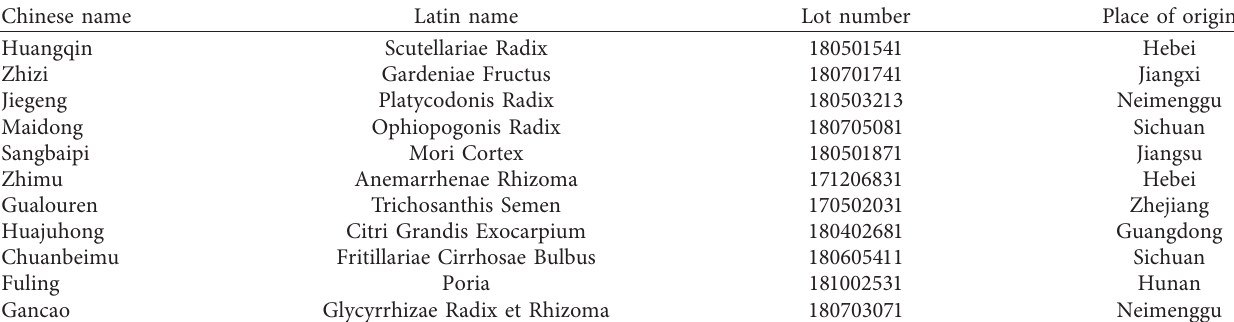
Table 1: Sources of the herbal materials of Qing Jin Hua Tan